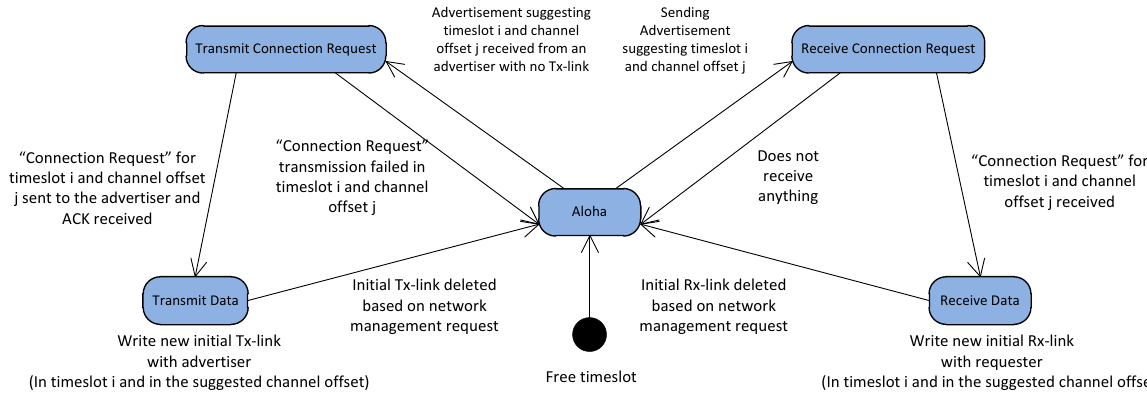
Figure 9. Different state of sample timeslot in the data communication period